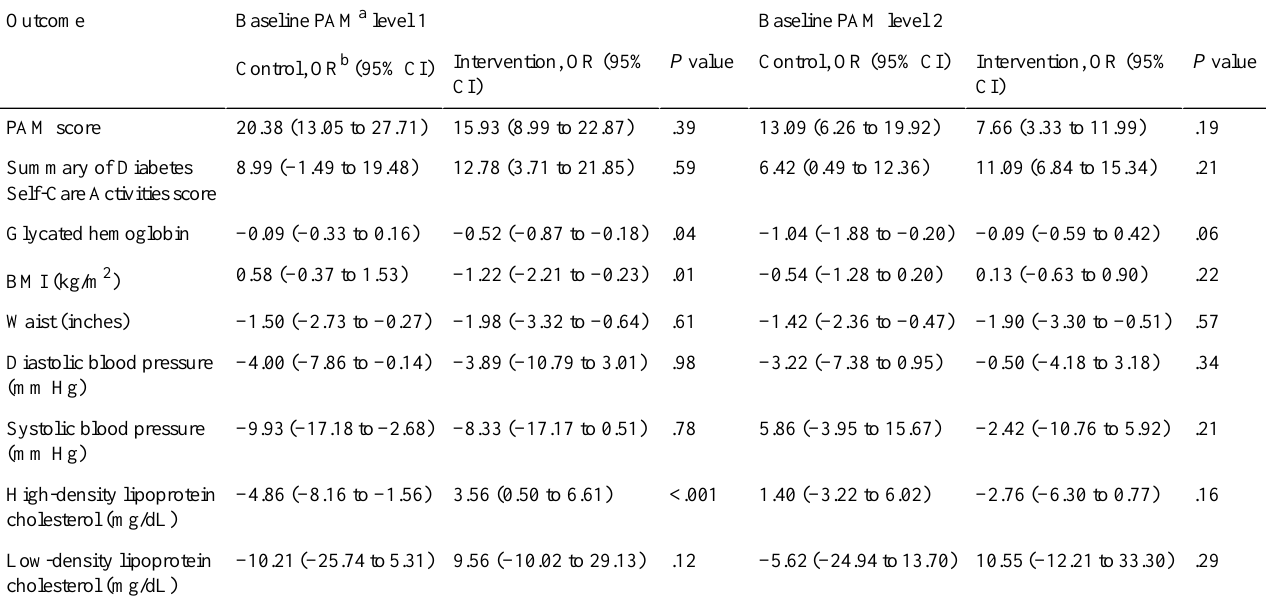
Table 5. Analysis of change from baseline to study end by baseline Patient Activation Measure level.